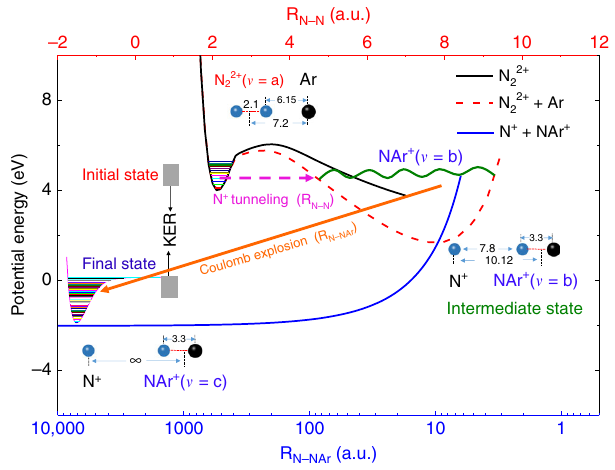
Fig. 4 Schematic diagram of heavy ion transfer process through ð X 1 Σ þ Þ Ar with/without the presence of neutral tunneling. The PECs of N 2 þ 2 g Ar along R N – N (upper horizontal axis) and N + – NAr + along R N – NAr (bottom ð X 1 Σ þ Þ without the neutral horizontal axis). The black solid curve for N 2 þ 2 g ð X 1 Σ þ Þ Ar at fi xed distance Ar, the red dashed curve for N 2 þ 2 g ¼ 7 : 2 a : u , and the blue solid curve indicates the PEC of N + – NAr + R N 2 (cid:2) Ar ¼ 3 : 3 a : u . The gray areas indicate the possibly populated initial with R N (cid:2) Ar and fi nal vibrational states of N 2 þ and NAr + ions, respectively, which 2 Ar contribute to the heavy ion transfer channel. The fi nal NAr + potential well is plotted on the left. The pink dashed arrow indicates the N + ion tunneling. The green wave line indicates the intermediate state of ion NAr + . The origin arrow indicates the fragmentation of N + and NAr + ion pair via Coulomb explosion. The origin of the potential energy curves is taken such that the potential energy of N + , N + , and neutral Ar at large separations is zero. The light blue ball represents nitrogen atom while the black ball represents argon ( v = c). The correlation between the KER of N + ion transfer channel and the initial states can be estimated. The initial energy ð X 1 Σ þ Þ Ar consists of a sum of of the doubly charged cluster N 2 þ 2 g minimum potential energy E i and vibration energy E a ( v = a).